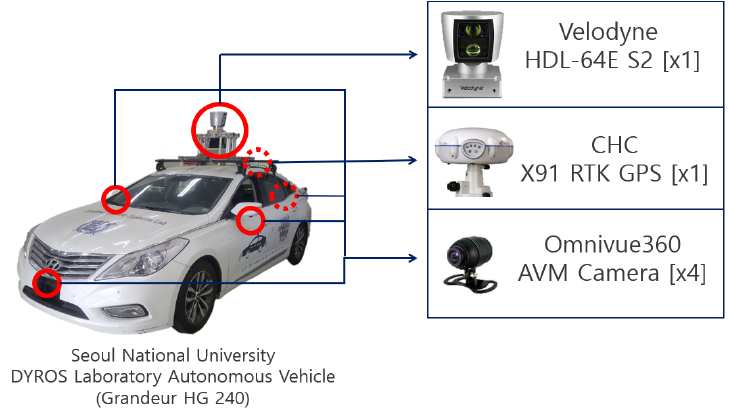
Figure 10. Sensor configuration of the autonomous vehicle. The autonomous vehicle of Seoul National University Dynamic Robotic System (DYROS) Laboratory was used.